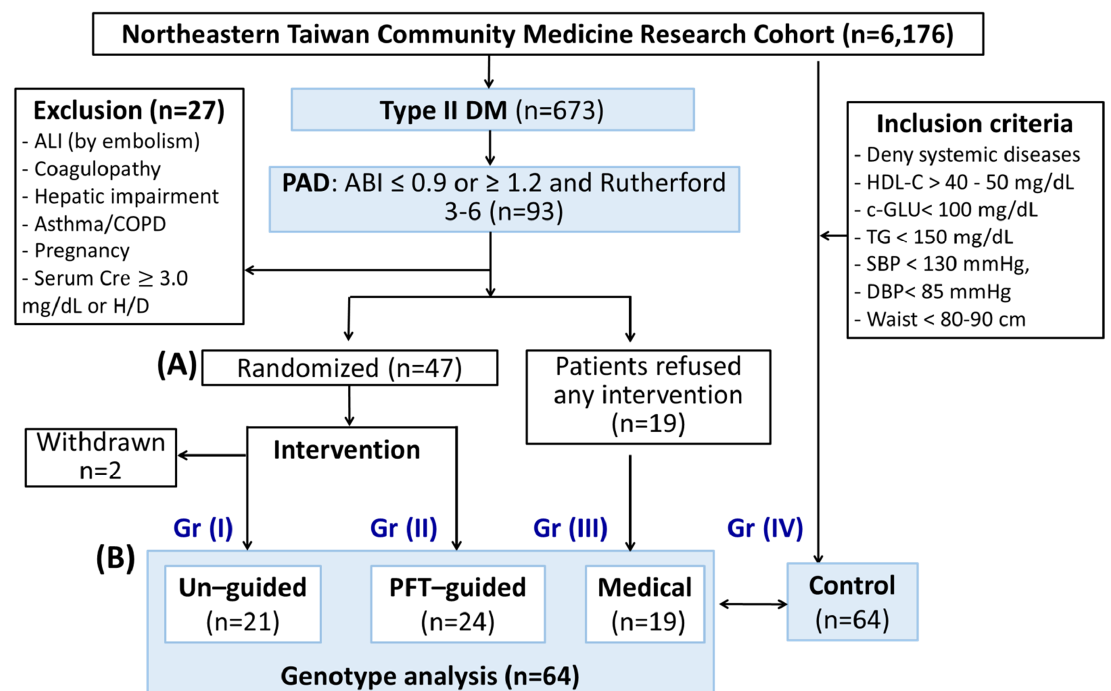
Figure 1. Patient flow diagram. ( A ) Patients were enrolled and prospectively randomized to platelet function test (PFT)-guided or control group. For the PFT group, the age of 20–75 years old, ABI ≤ 0.9 or ≥ 1.2, and Rutherford 3–6 were included. The subjects in the control group were selected according to the following criteria: denied systemic diseases (such as cancer, stroke, diabetes, COPD, CAD, CKD, hypertension, hyperlipidemia), HDL-C > 40 mg/dL (male) or > 50 mg/dL (female), Ac-GLU < 100 mg/dL, TG < 150 mg/dL, systolic blood pressure (SBP) < 130 mmHg and diastolic blood pressure (DBP) < 85 mmHg, and waist circumference < 90 cm (male) or < 80 cm (female). After PAD intervention, patients in the control group received aspirin and clopidogrel for 36 months. Patients with clopidogrel resistance in the PFT-guided group received aspirin and ticagrelor in replacement of clopidogrel. The dosage of ticagrelor was directed by results from their PFT. ( B ) All the genomic DNA of patients enrolled in the study was analyzed and compared to that of age- and sex-match subjects from the Northeastern Taiwan Community Medicine Research Cohort.